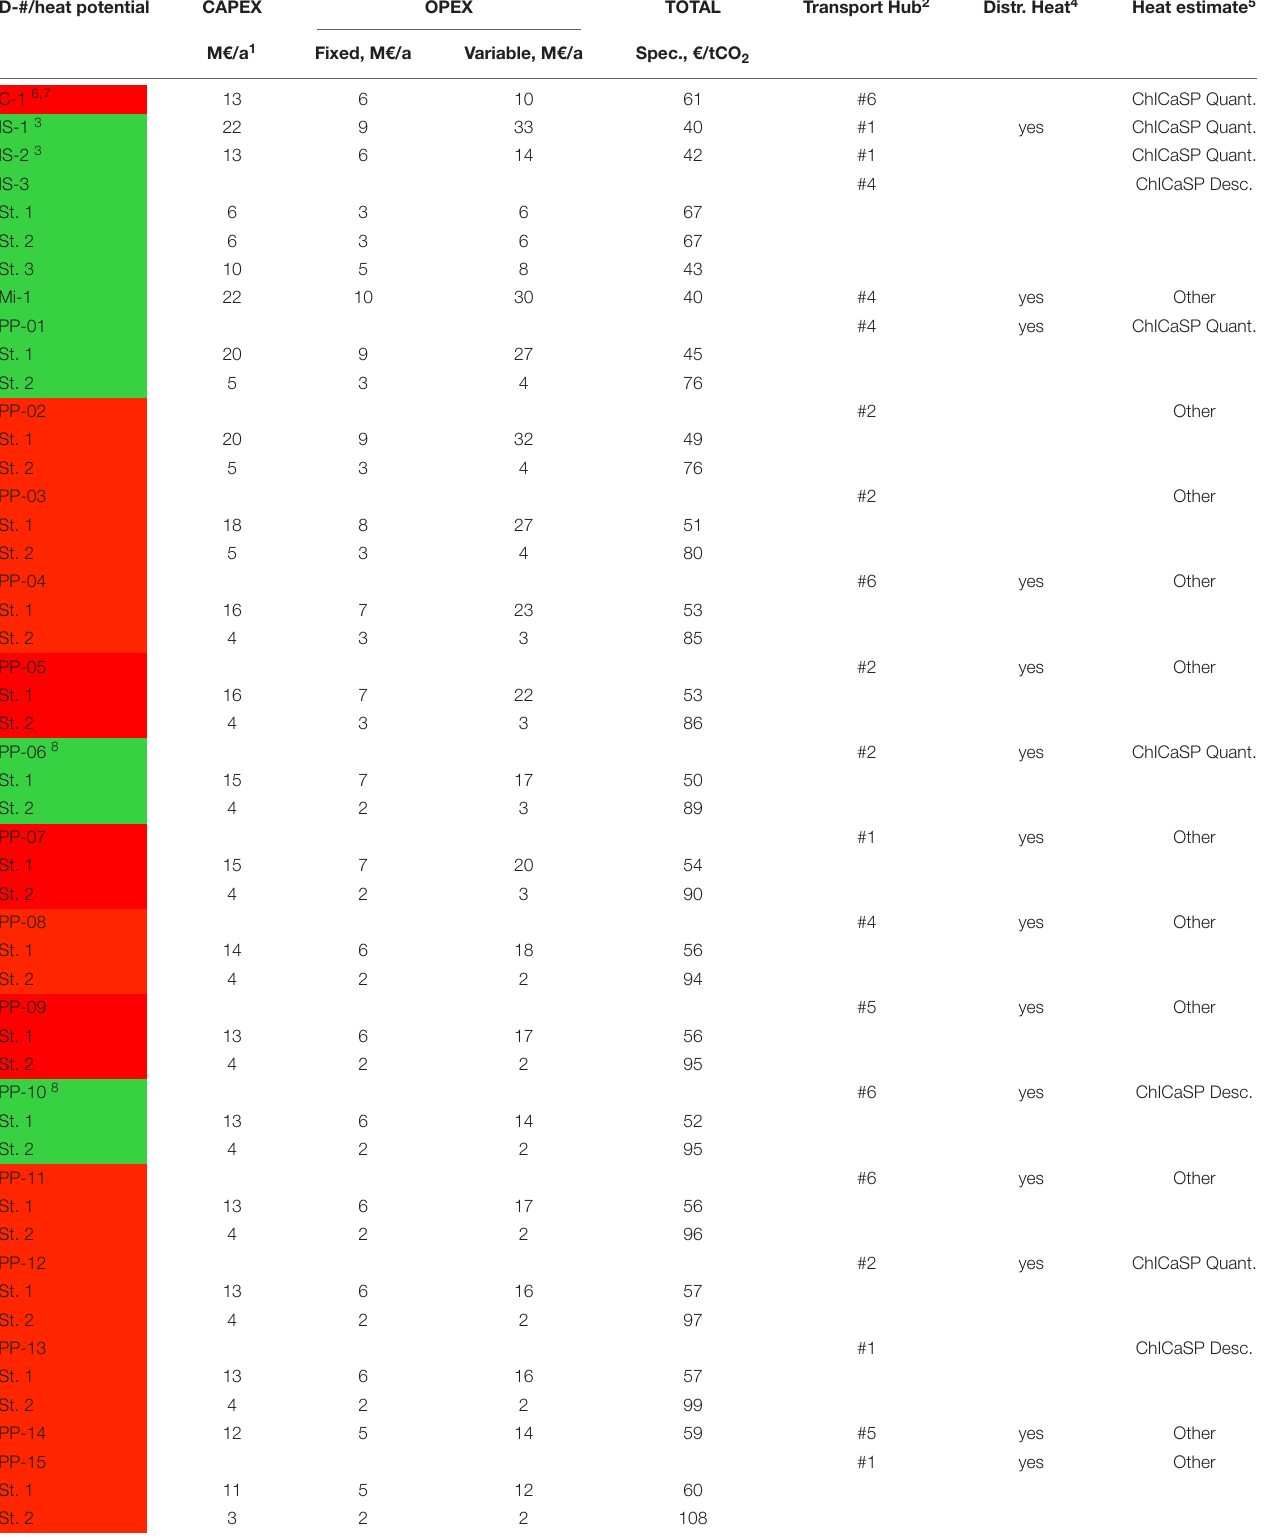
TABLE 5 | Mapping of potential for implementing carbon capture and storage at Swedish emission sources > 500 kt/a. ID-#/heat potential CAPEX OPEX TOTAL Transport Hub